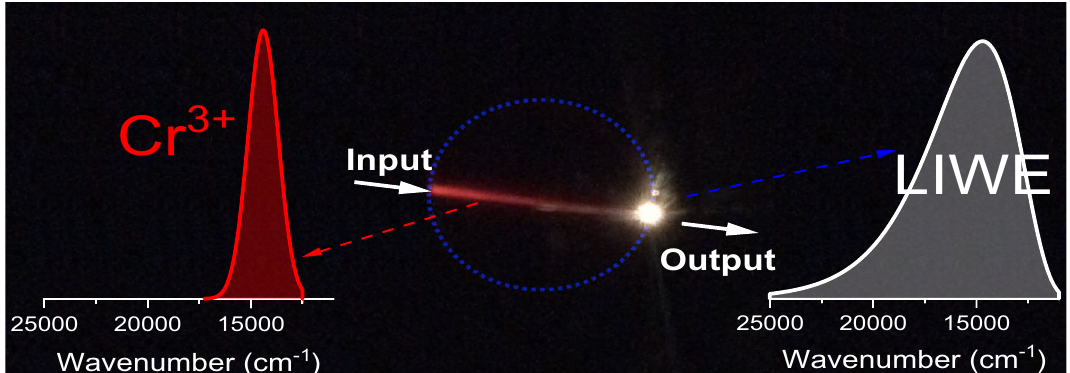
Figure 3. The photo of Cr:YAG ceramics under 1064 nm laser excitation in vacuum and emission spectra observed under focused 1064 nm laser beam. The blue circle indicates the shape of the sample.